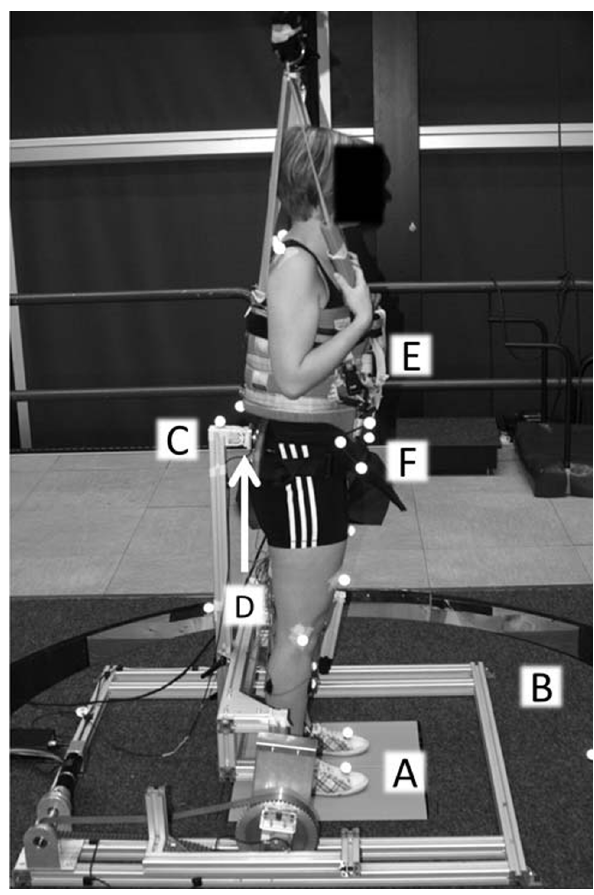
Figure 1. Experimental set-up. Participants stood on the dual forceplate (A), with their arms crossed over their chest, embedded in the movable platform (B). Two independent perturbations in the forward-backward direction were applied simultaneously using both the movable platform (B) and the pusher (C). Interaction forces between the pusher (C) and the participant were measured with a force sensor (D). Actual falls were prevented by the safety harness (E), which did not provide any support or directional cues. Reflective spherical markers (F) measured movements of the participant.